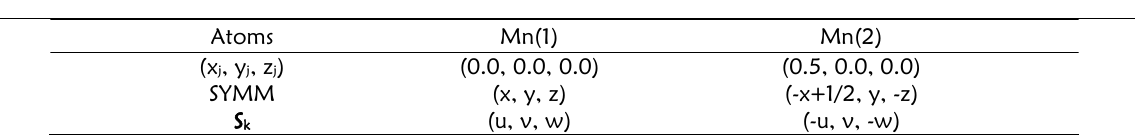
Table 7. Basis functions of Representation IRrep (1) of LaMnO 3 , space group: I12/a1, magnetic symmetry